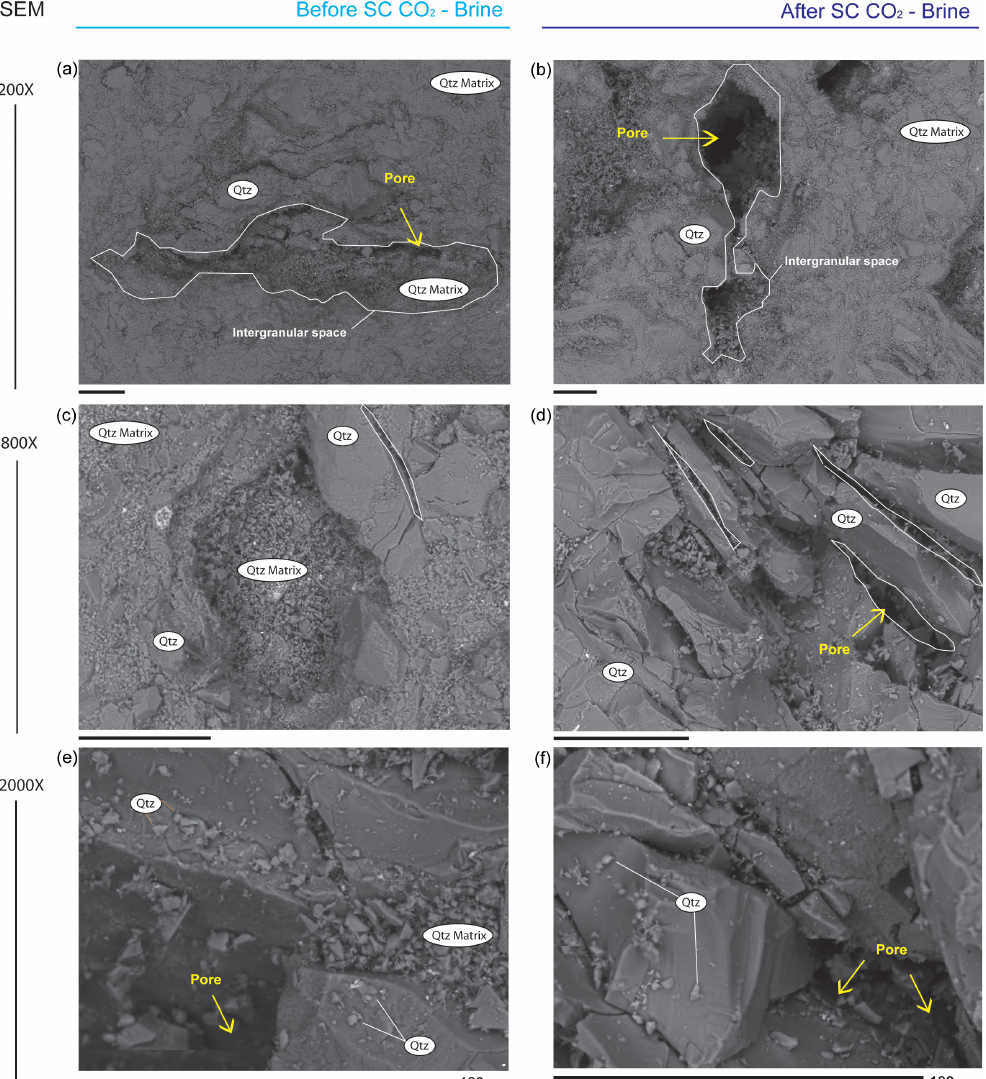
Figure 5. Secondary electron SEM micrographs of the Utrillas sandstones. Left images (a, c and e) correspond to samples before SC CO 2 injection. Right images (b, d and f) correspond to samples after SC CO 2 injection. (a) Intergranular space filled with minerals; (b) intergranular spaces constituted by cavern pores interconnected by micro-channels with pore spaces sometimes filled with minerals; (c) intercrystalline space; (d) high degree of fracturation of quartz grains; (e) the edges of quartz grains in the starting material (before CO 2 - brine exposure) contain angular pits; (f) pits in quartz from the experiment are less numerous and distinctly rounded and